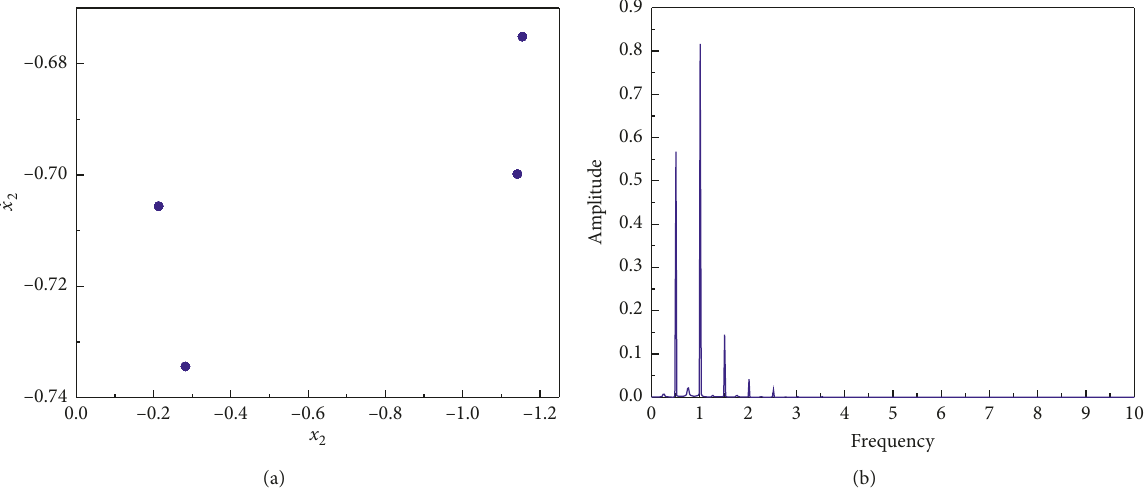
Figure 16: Period-4 motion of the baseplate for Ω � 1 . 01.